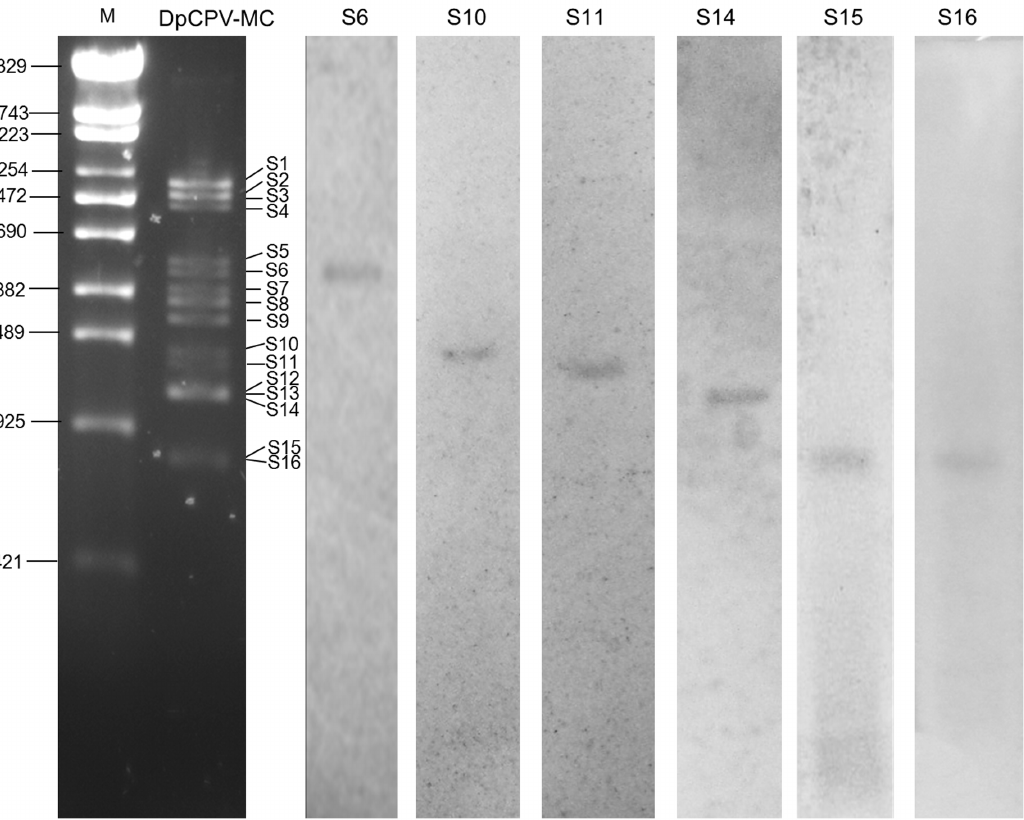
Figure 5. Northern blot analysis of six dsRNA segments of DpCPV-MC. Total genomic dsRNA of DpCPV-MC was separated on 1% agarose gel, transferred to nylon membrane, and hybridized with the corresponding DIG-labeled probes derived from each of the six segment sequences. The left part is agar gel stained with ethidium bromide. M, phage l DNA digested with Eco T14 I. The right six lanes are northern blot results.